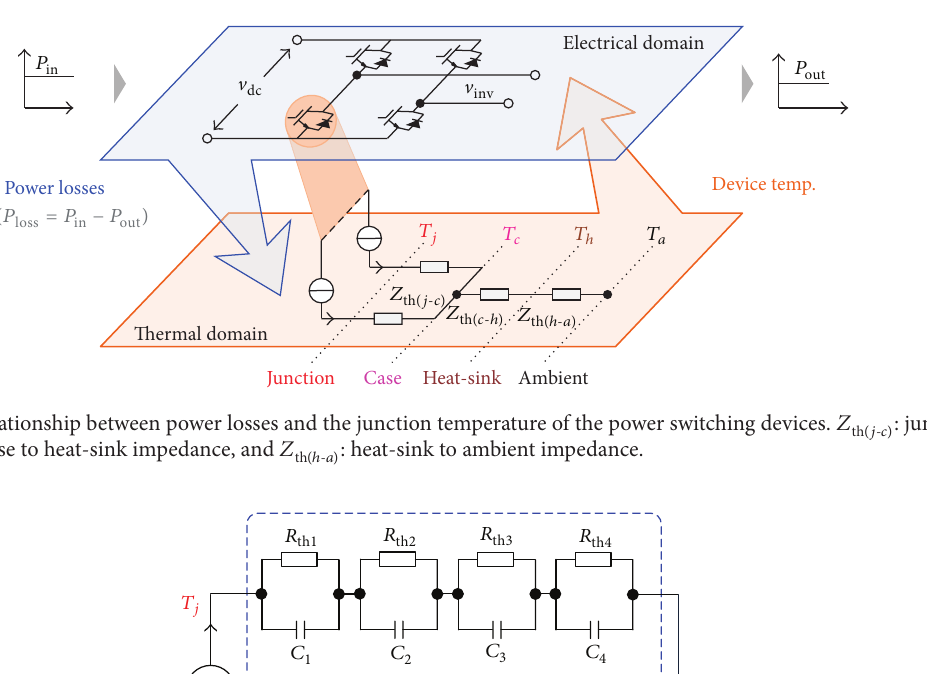
Figure 6: Foster model of the junction to case thermal impedance 𝑍